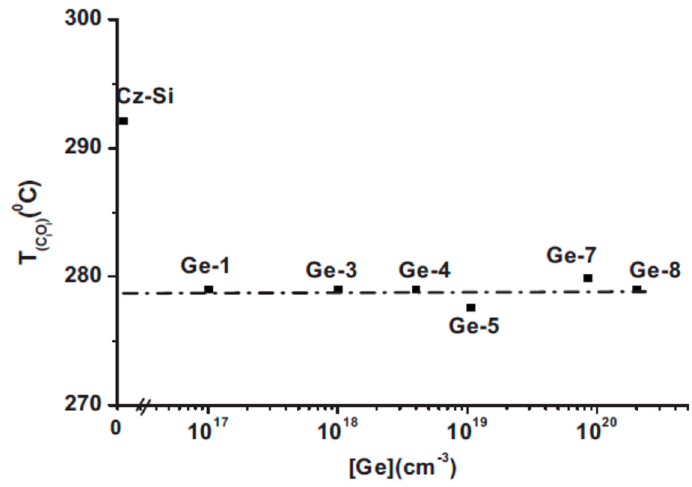
Figure 25. The annealing temperature T ann of the C i O i defect as a function of the Ge concentration Reproduced with permission from [128]. American Institute of Physics, 2010.